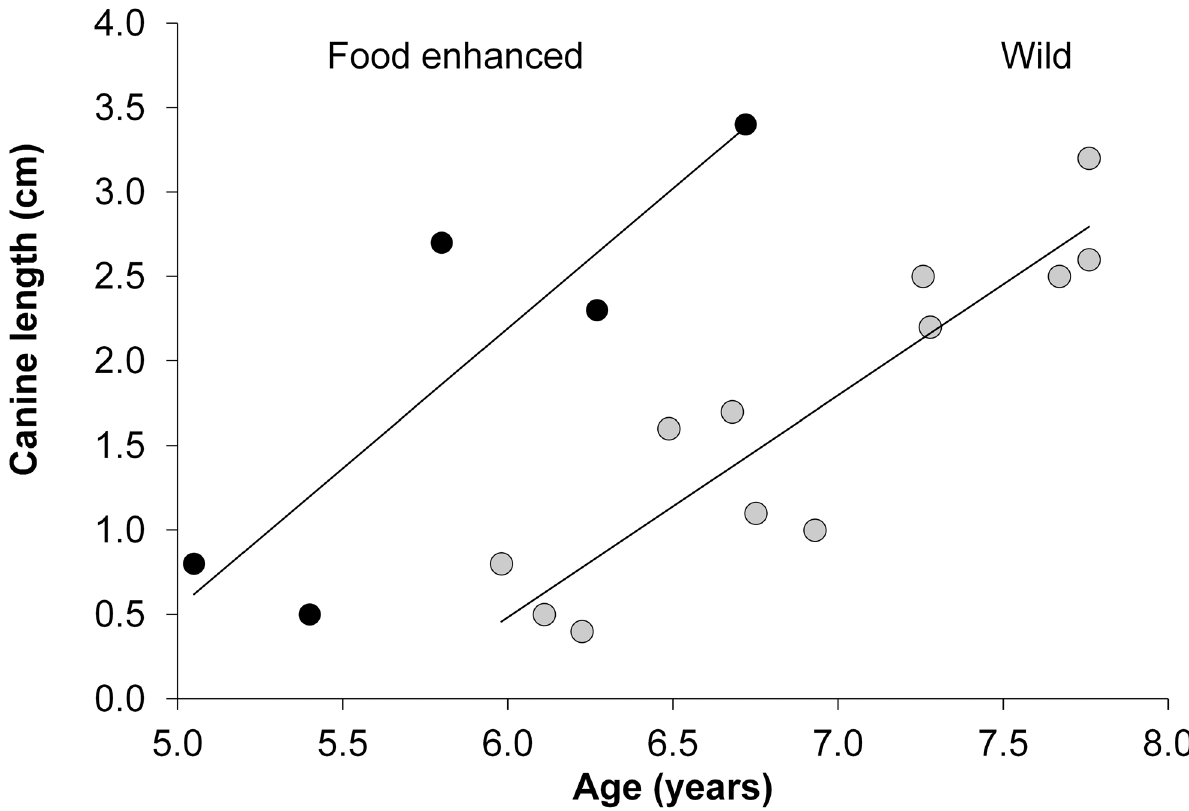
Fig 1. Canine length during maturation: linear regressions of canine length on age for wild-feeding and food-enhanced males who had not reached adulthood. In the equations, y is the response variable and R 2 is the proportion of variance in the response variable that is associated with the predictor